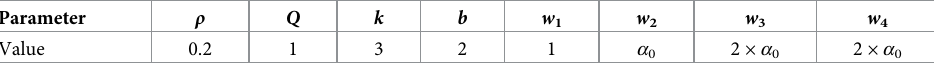
Table 3. Model parameters used in numerical experiments. The parameter α 0 = max{ α 0, between the depot 0 and patient locations j of each instance.